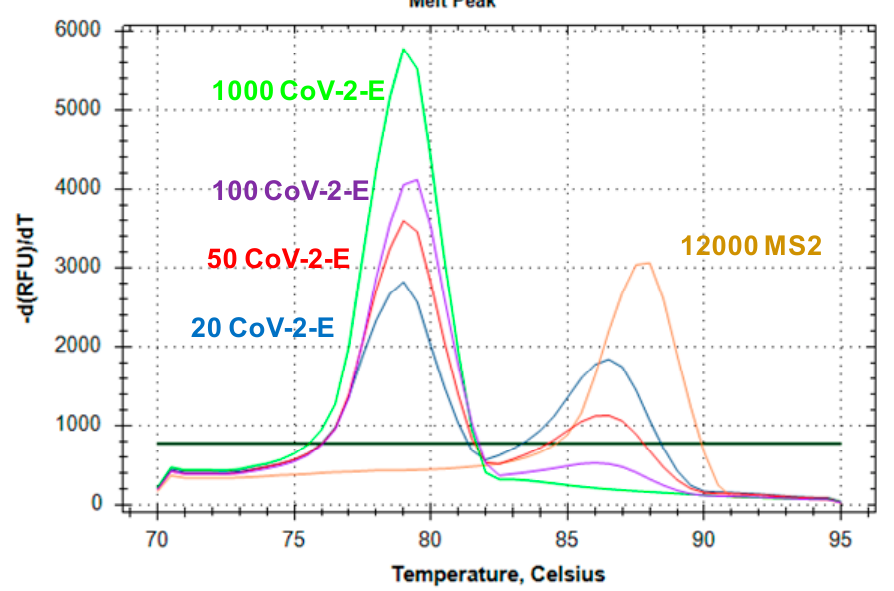
Figure 5. The melting curve analysis of the LAMP products: evaluation of the limit of detection for the MS2-CoV-2 duplex. The graph represents characteristic melting peaks for LAMP products obtained with the CoV-2-E monoplex and CoV-2-E RNA template (green curve), with the MS2 monoplex and MS2 RNA template (orange curve), with the MS2-CoV-2-E duplex, 12,000 copies/reaction MS2 RNA template, and with CoV-2-E RNA: 100 copies (purple curve), 50 copies (red curve) and 20 copies (blue curve).